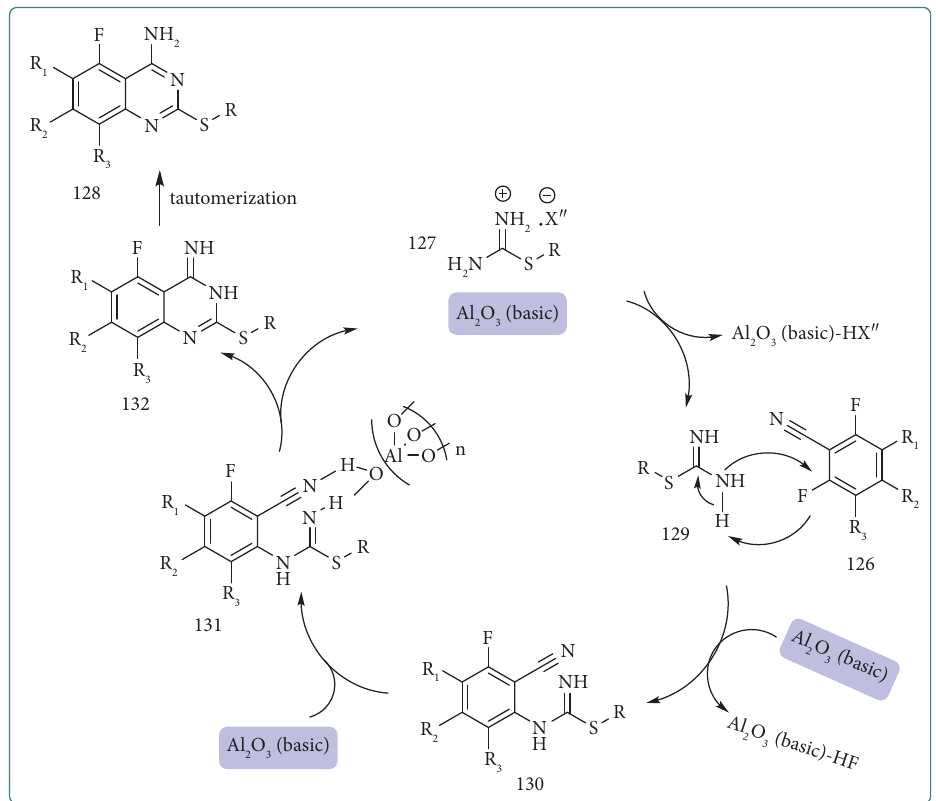
Figure 15: Te proposed mechanism for the synthesis of fuorinated 2-alkylthio-4-aminoquinazolines under microwave